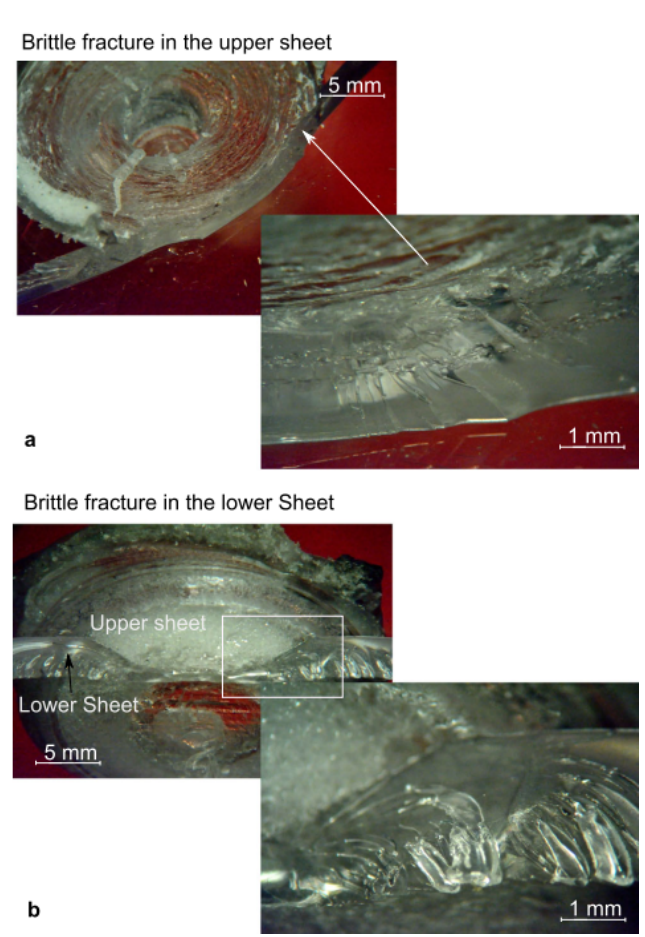
Figure 28. Fracture surfaces characterized by brittle failure [77]: (a) upper sheet and (b) lower sheet.